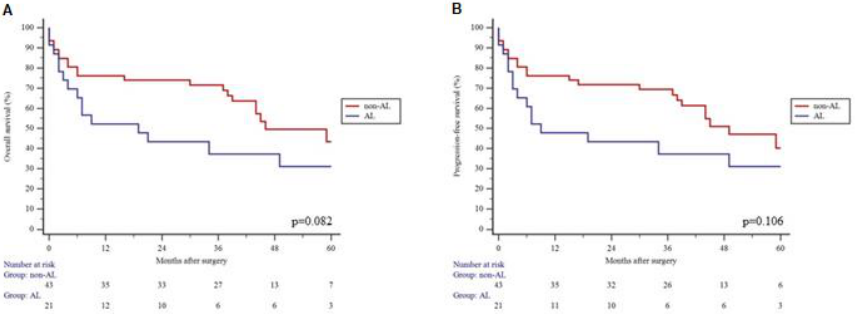
Figure 1. 3-year overall survival ( A ) and progression-free survival ( B ) in anastomotic leak (AL) group vs. no leak (non-AL) group.